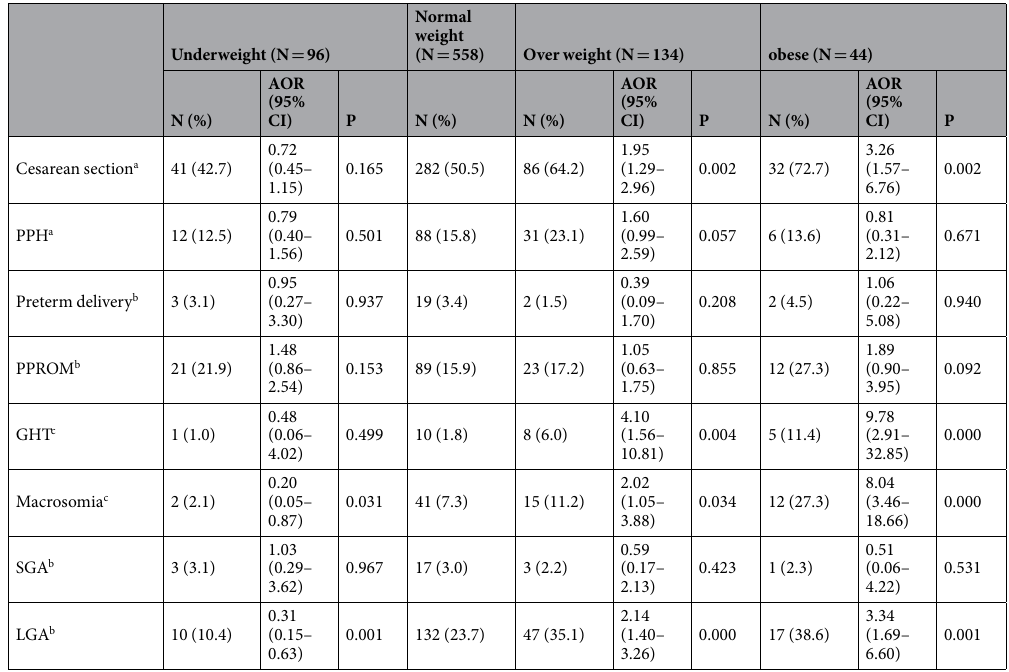
Table 3. Effects of pre-pregnancy body mass index on pregnancy outcomes. AOR, adjusted odds ratio; CI, confidence interval; PPH, postpartum hemorrhage; PPROM, preterm premature rupture of membranes; GHT, gestational hypertension; SGA, small for gestational age; LGA, large for gestational age. AORs are presented relative to the normal weight group. a Adjusted for maternal age, gestational weeks, gestational weight gain and birth weight; b adjusted for maternal age and gestational weight gain; c adjusted for maternal age, gestational weeks and gestational weight